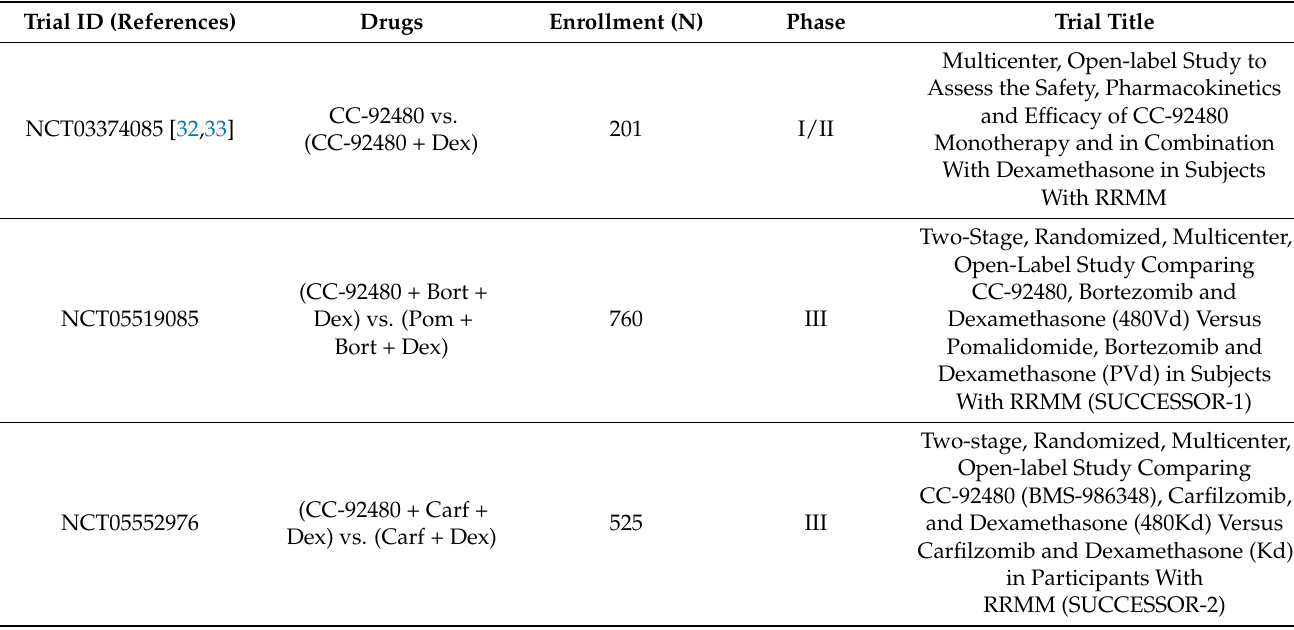
Figure 2. Structures of Immunomodulators (Cereblon E3 Ligase Modulators) With Activity Against MM. Table 1. Selected Active Myeloma-based Trials of Cereblon E3 Ligase Modulators.